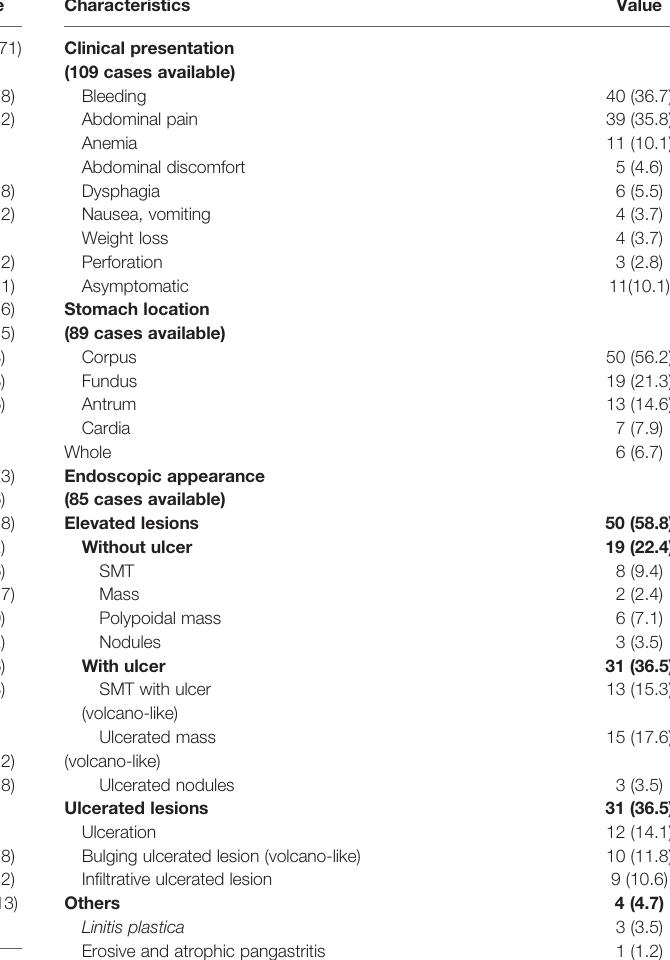
TABLE 1 | Demographic and clinicopathologic features of GMLC. TABLE 2 | Clinical and endoscopic features of gastric metastatic